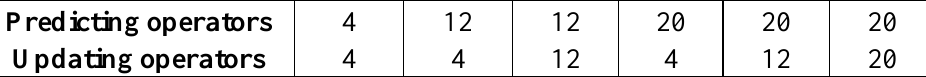
Table 1. Selection of predicting operators and updating